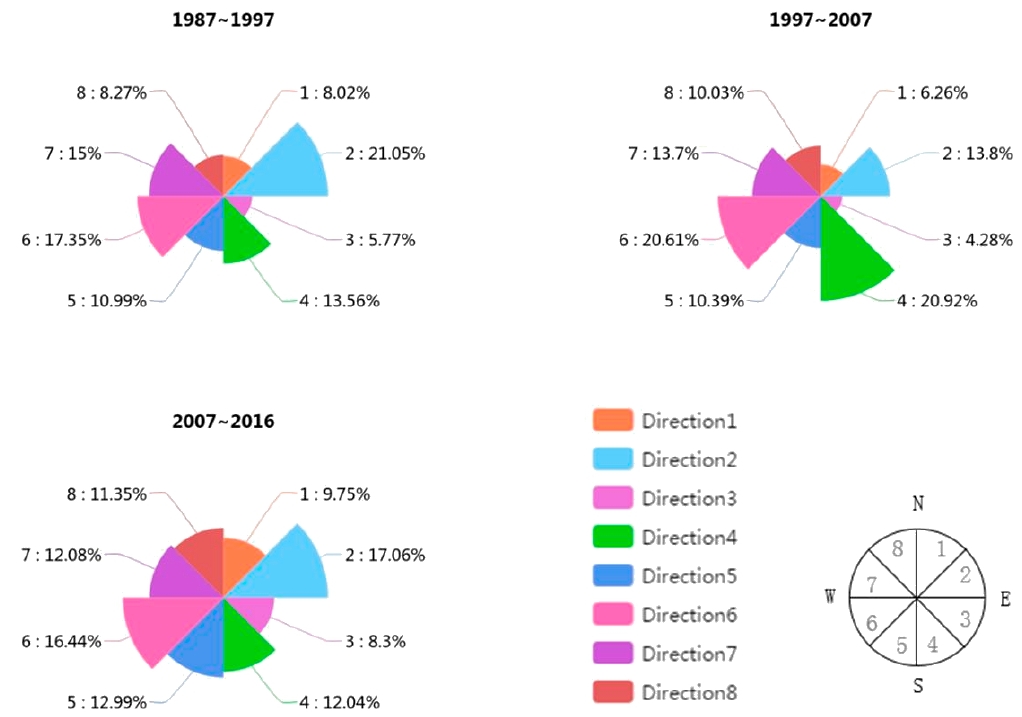
Figure 10. The impervious surface expansion in eight directions from 1987 to 2016.